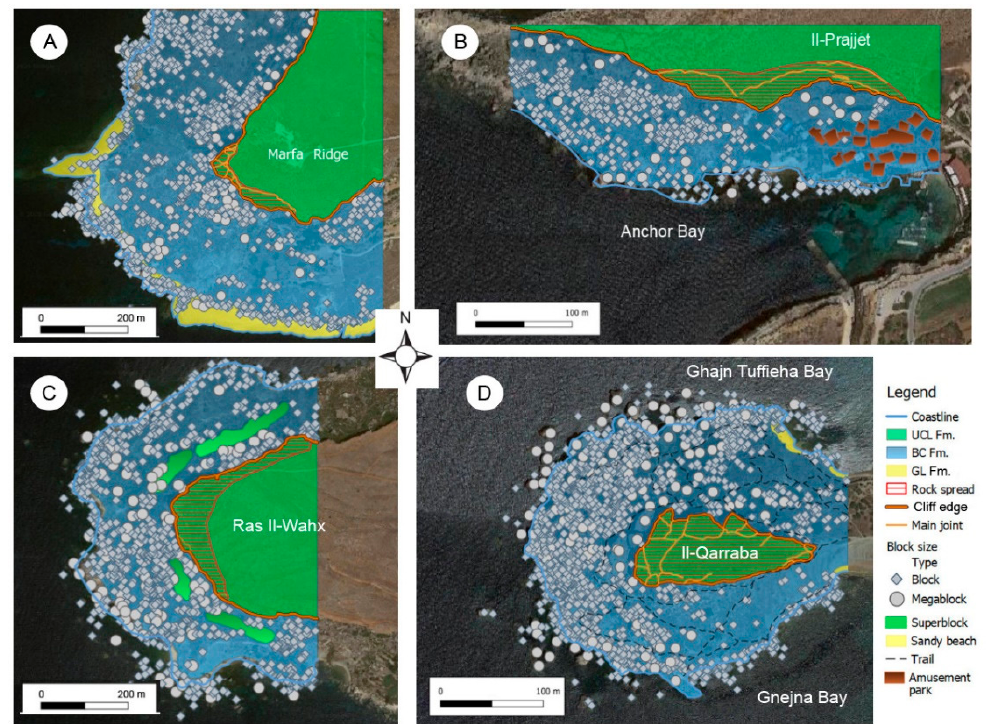
Figure 8. The spatial distribution of categorized megaclasts of: ( A ) Marfa Ridge; ( B ) Anchor Bay; ( C ) Ras Il-Wahx headland; and ( D ) Il-Qarraba peninsula. Table 6. Megaclast size analysis within the study sites using GE images. Location Block Megablock Superblock Marfa Ridge